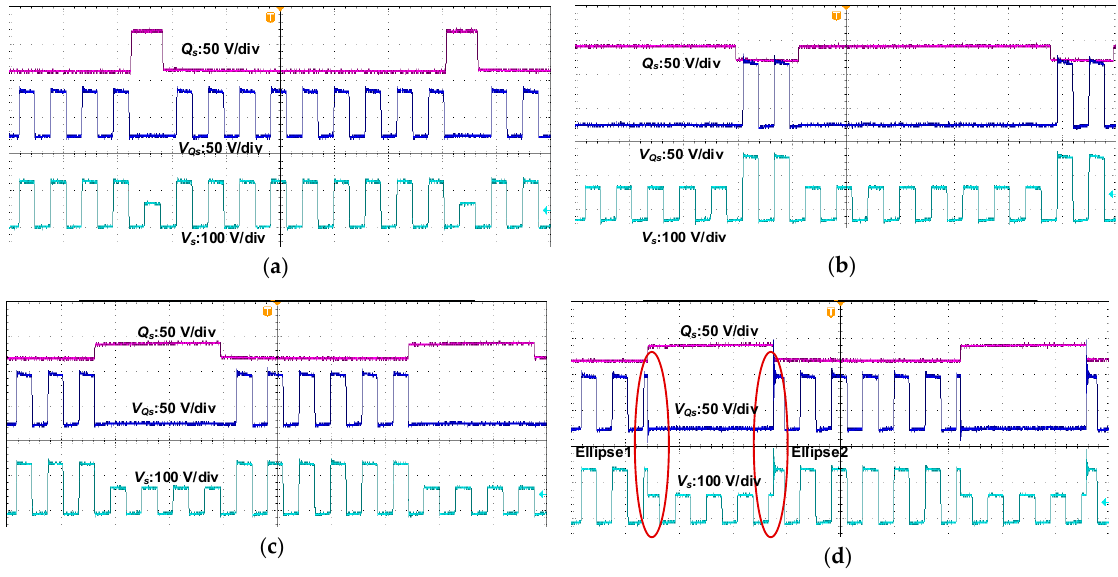
Figure 16. Waveforms of V s and V Qs with different d Qs : ( a ) d Qs = 0.1 ( b ) d Qs = 0.8 ( c ) d Qs = 0.4 ( d ) d Qs = 0.4 but hard switching.